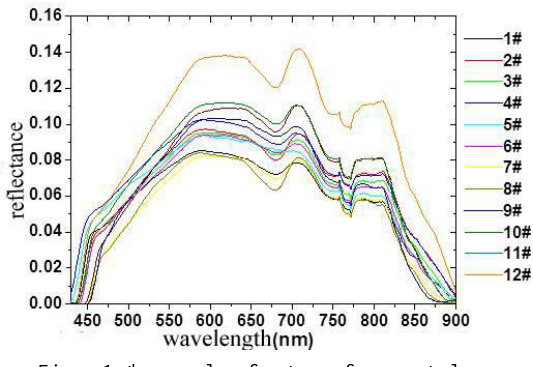
Figure 1. the samples of water surface spectral